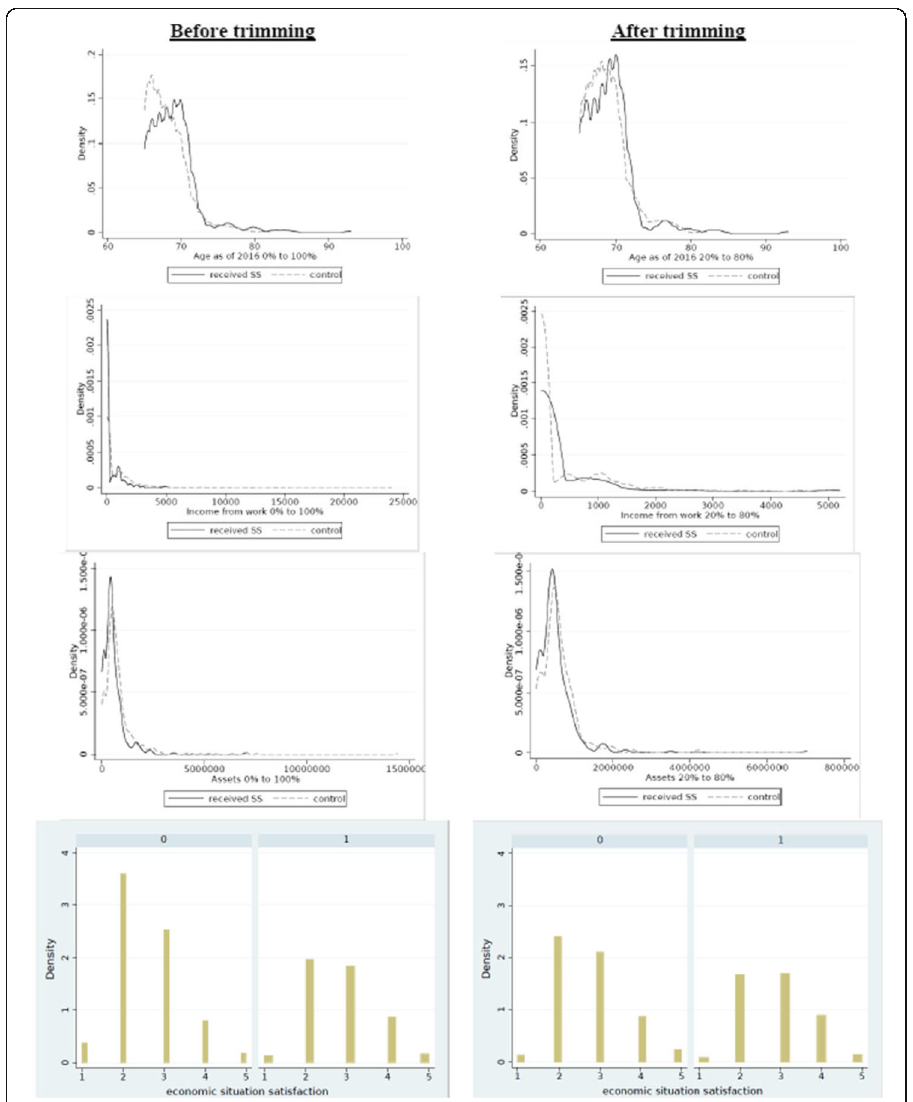
Fig. 1 Density plots/histograms of key demographics before (left panel) and after (right panel) trimming (Note the change in scale of the horizontal axis after